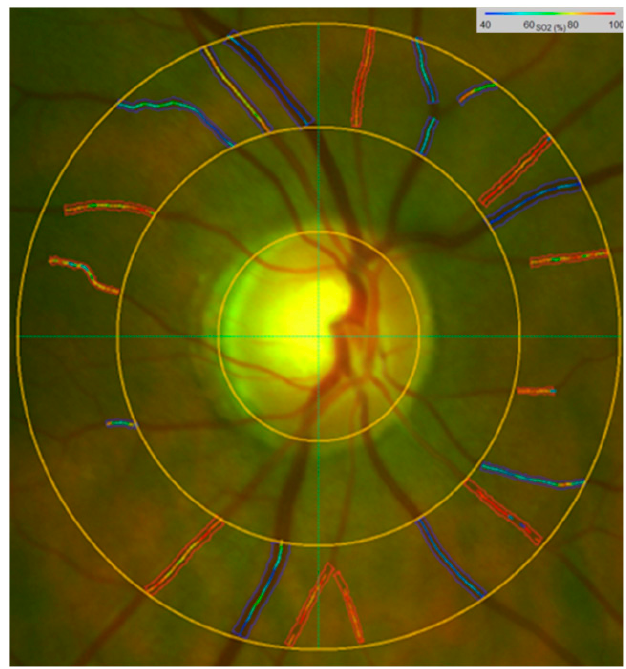
Figure 1. A vessel map of the retinal oximetry image (RO) shows color-coded oxygen saturation (SO 2 ) values of retinal vessels within the peripapillary annulus of a glaucoma patient (right eye). We evaluated the average SO 2 parameters (A-SO 2 , V-SO 2 and A-V SO 2 ; %).